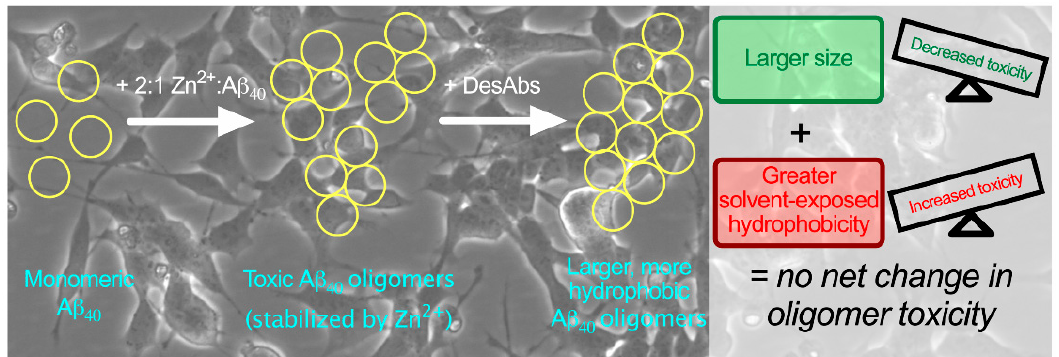
Figure 8. We have used rationally designed antibodies (DesAbs) as molecular tools to investigate the size-hydrophobicity-toxicity relationship of A β 40 oligomers. Incubation with DesAbs increased the size and hydrophobicity of Zn 2 + -stabilized A β 40 oligomers. These physicochemical changes decrease and increase the toxicity of these particular model oligomers, respectively, resulting in no net overall change in their toxicity upon administration to cultured human neuroblastoma cells.